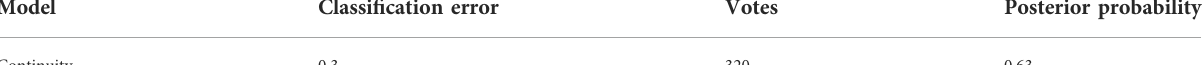
TABLE 2 Model selection. Best model selected (highlighted in bold) by the ABC-RF procedure.